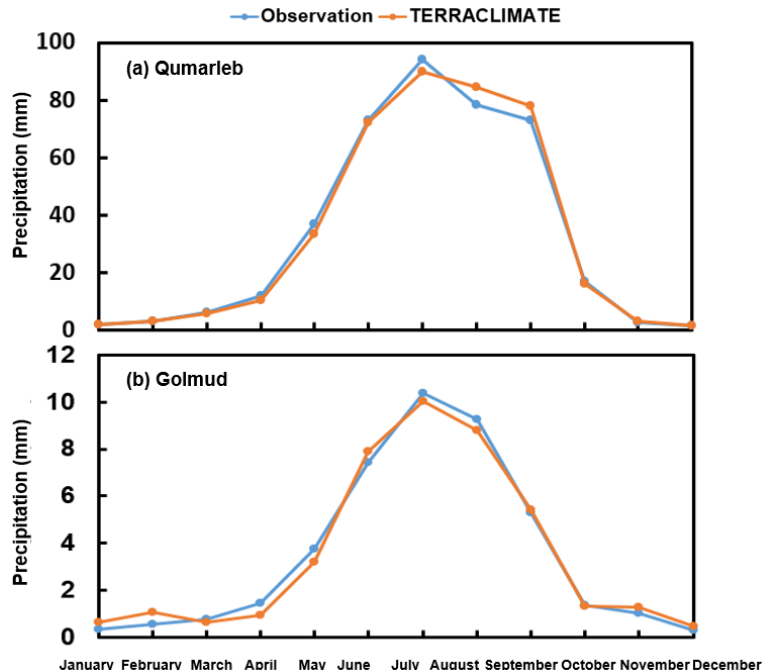
Figure 2. Mean monthly precipitation observed at typical meteorological stations and extracted from TERRACLIMATE data: ( a ) the Qumarleb meteorological station; ( b ) the Golmud meteorological station.